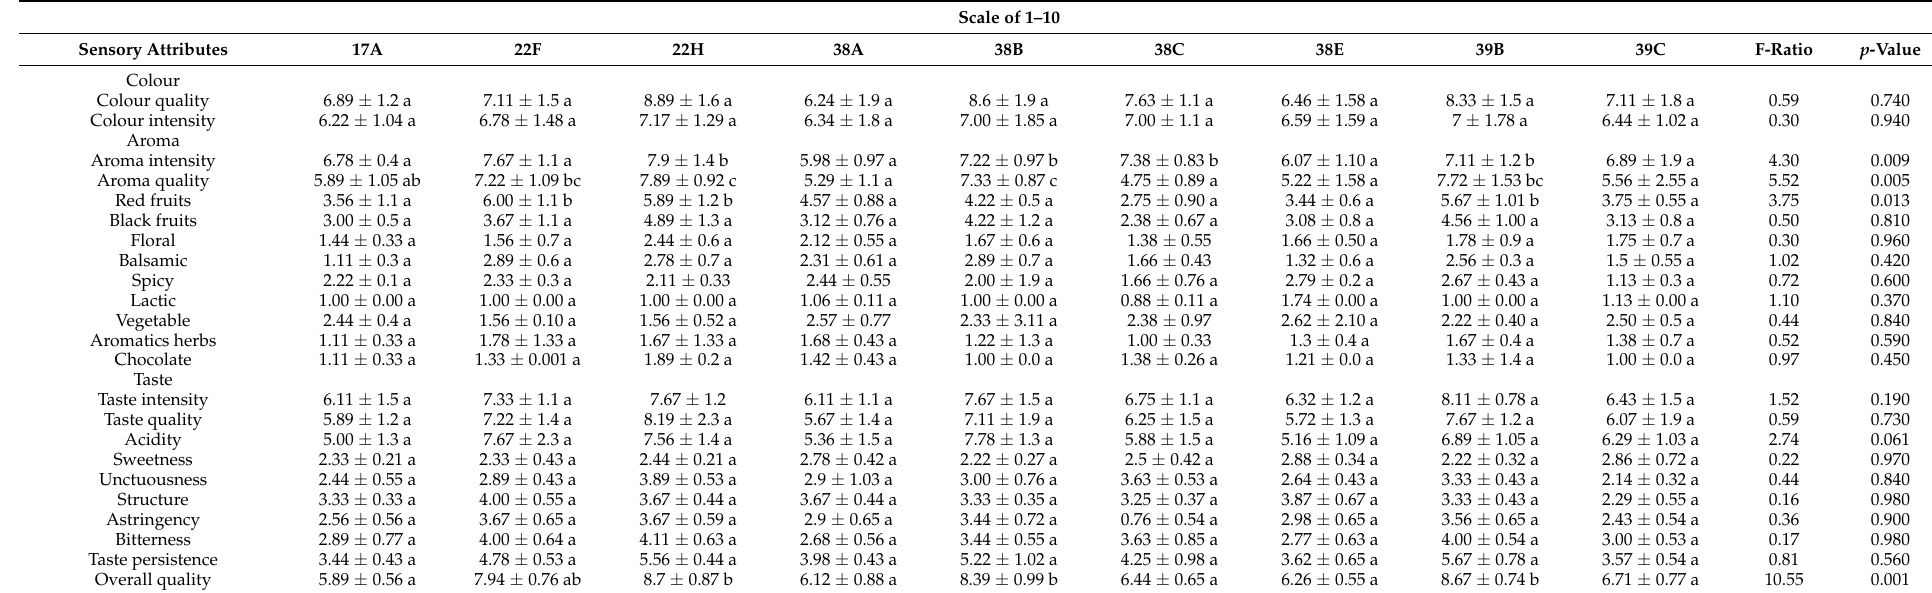
Table 5. Effect of fermentation with selected yeast strains on the sensory attributes of Garnacha wines.